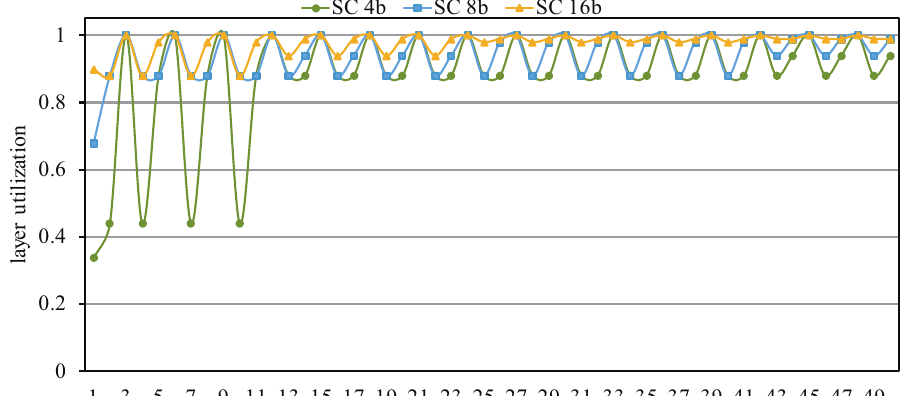
Figure 15. Layer utilization for different bit widths with ResNet50.